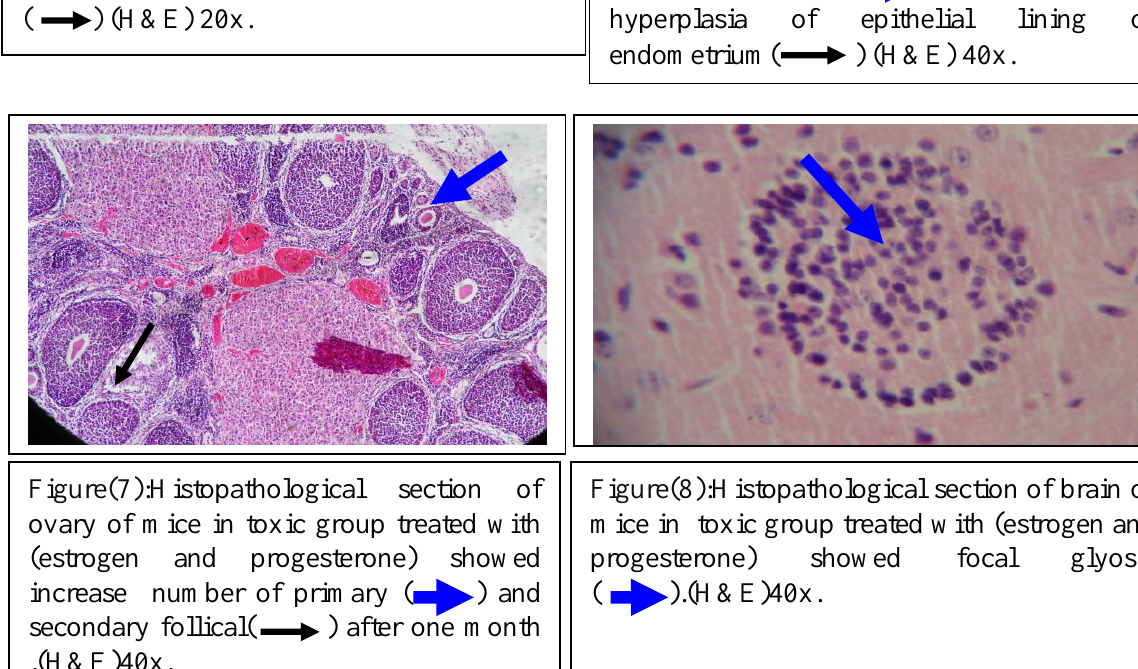
Figure(5): Histopathological section of uterus of mice in toxic group treated with (estrogen&progesterone)showed osinophilic haemogenous substances appear in the lumen of endometrial gland( ) with papillary projection extend to the lumen